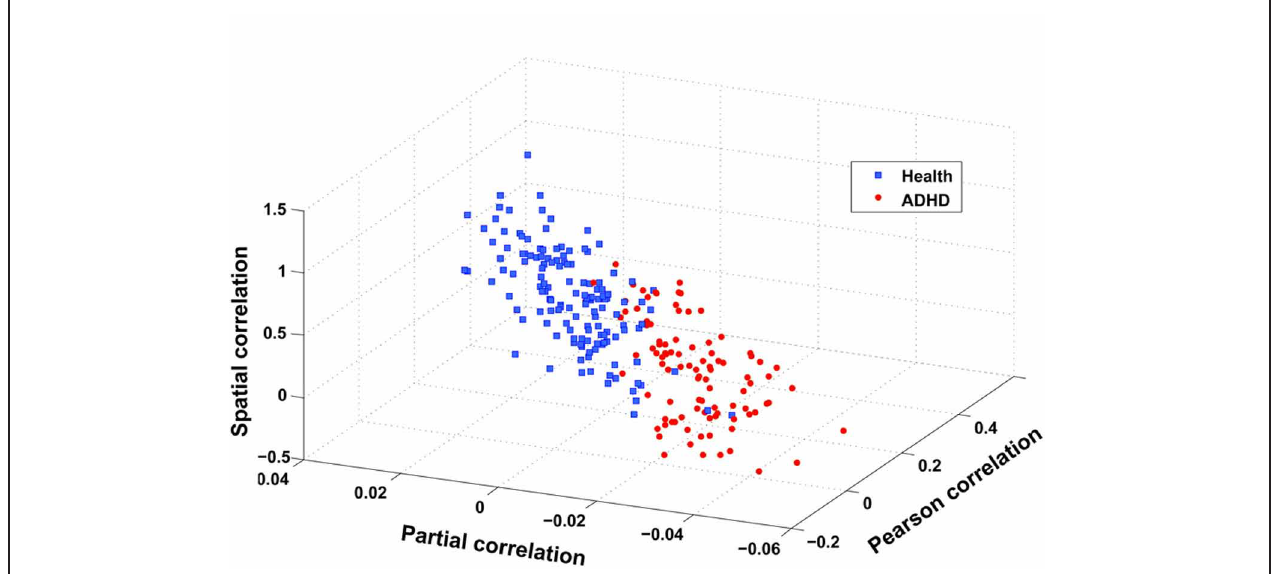
FIGURE 5 | Scatter plot of three features after integration, i.e., spatial correlation, partial correlation, and Pearson correlation (CC400). These three features are obtained in the following way: taking spatial correlation for